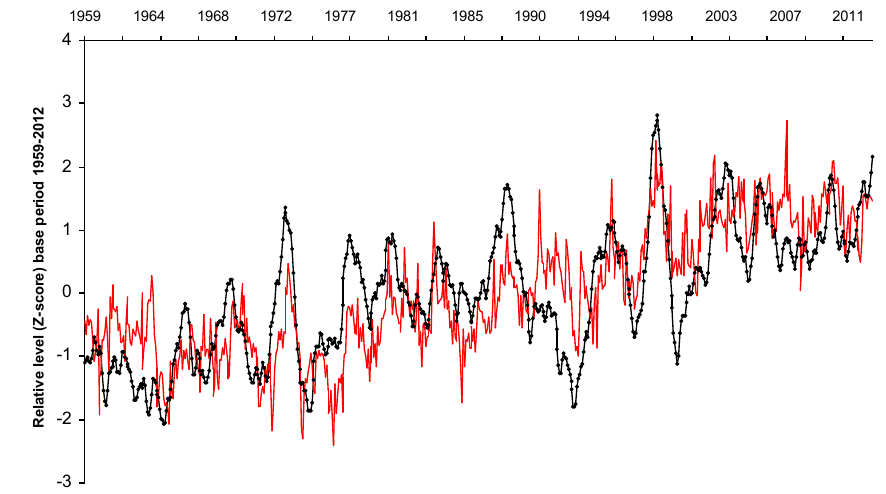
Figure 3. Z -scored monthly data: global surface temperature (red curve) compared to first-difference atmospheric CO 2 smoothed by two 13-month moving averages (black dotted